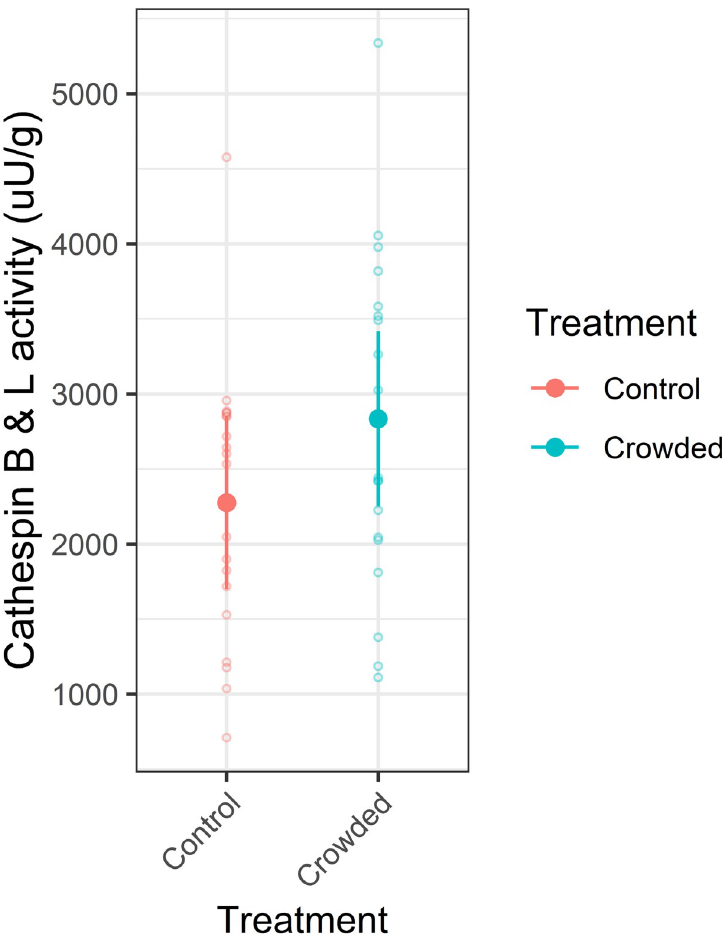
Fig 5. Cathepsin B & L activity response to crowding in Atlantic mackerel. Cathepsin activity was determined seven days after death for fish from the net pen experiment. Model predicted mean values are shown as filled circles, with associated 95% confidence intervals as whiskers. The underlying dataset is shown as open circles. Data points are coloured according to treatment.